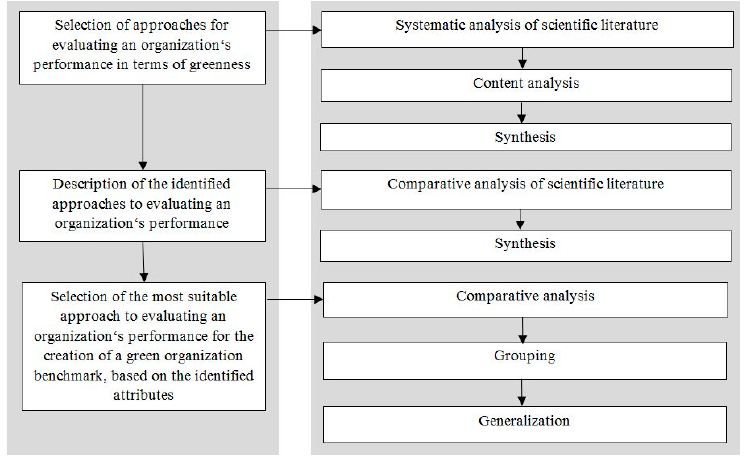
Figure 2. Methodological scheme of the research (source: composed by the authors).